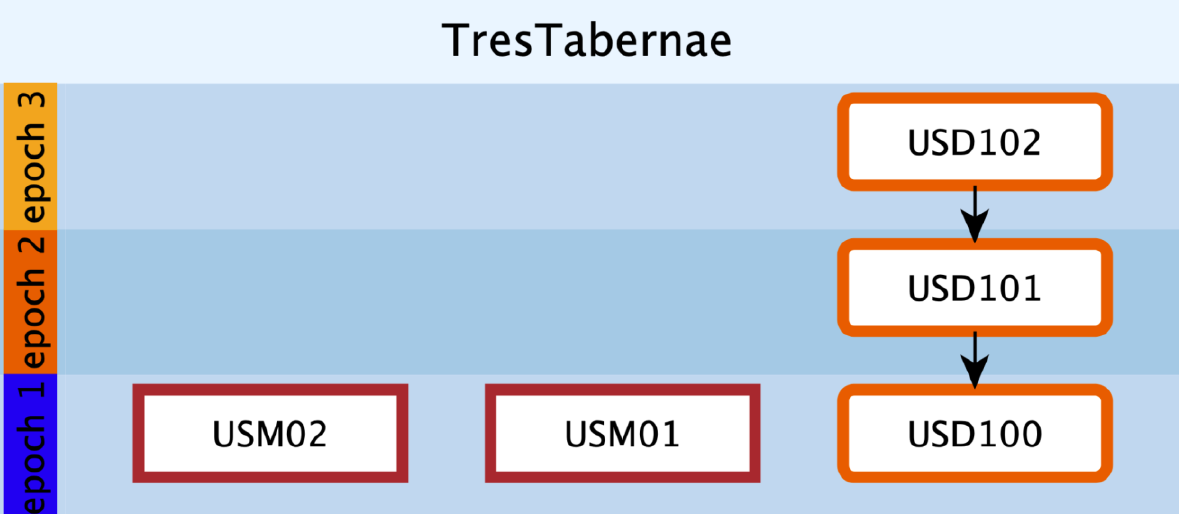
Figure 12. Visualization of EM related to structures found in the subsurface and related supplemen- tary volumes.